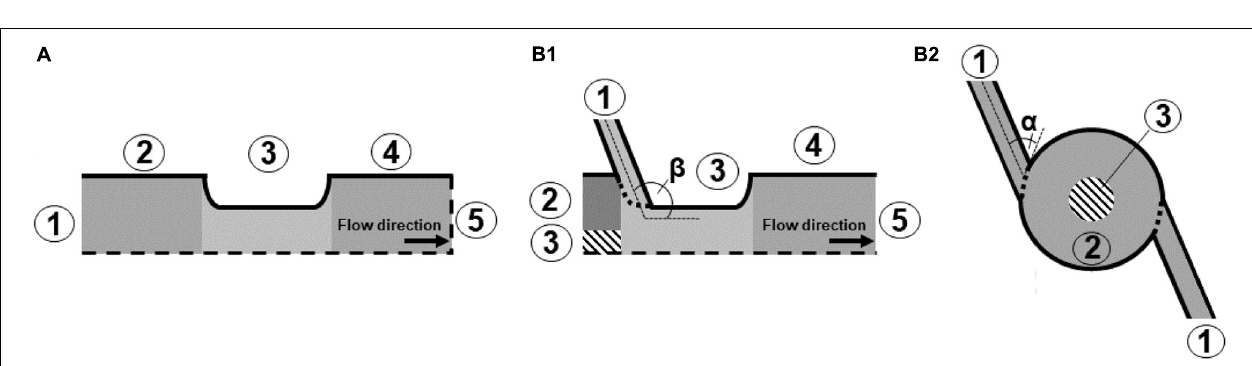
FIGURE 1 | Cross sections of the two different designs used in this study, i.e., co-linear (A) and vortex (B) PEF treatment chamber configurations, including the final dimensions. Depicted are the flow-through ground (1a) and high voltage (3) electrodes, and disk-shaped flow-through insulators (2a). For the vortex configuration, a solid ground electrode (1b) and the specific bottom insulator design (2b) were implemented. The remaining configuration was unchanged. More information on the co-linear chamber and further dimensions are provided by Meneses et al. (2011a).